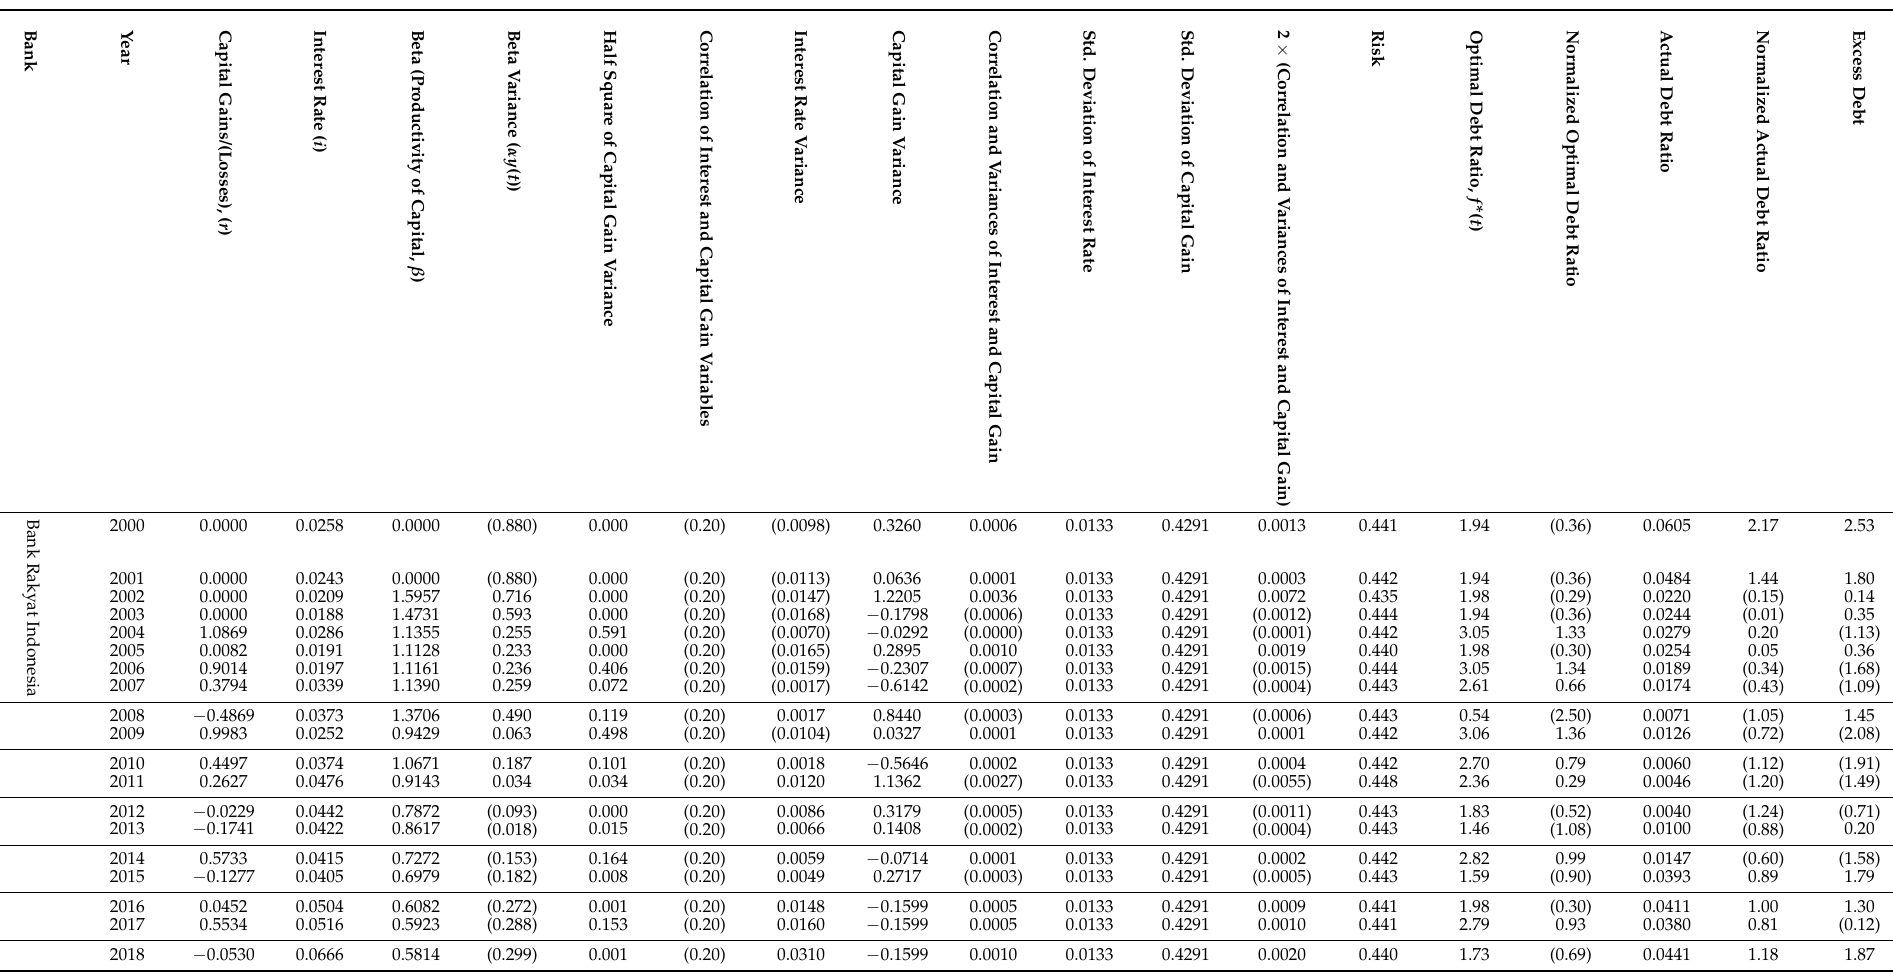
Table A11. Calculations of Optimal and E × cess Debt: Bank Rakyat